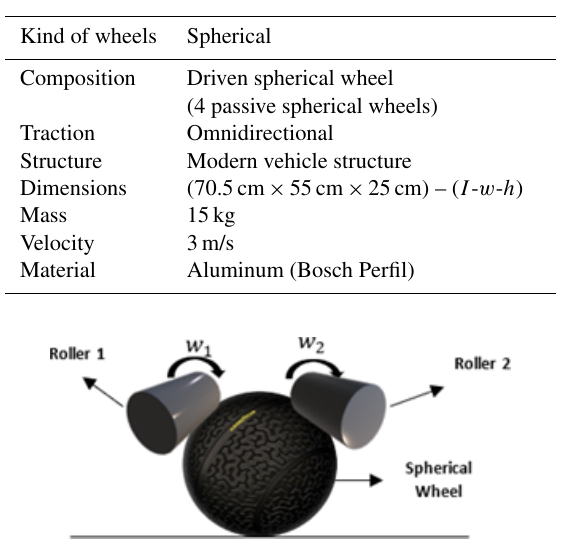
Table 1. Features of pressure cleaning robot.